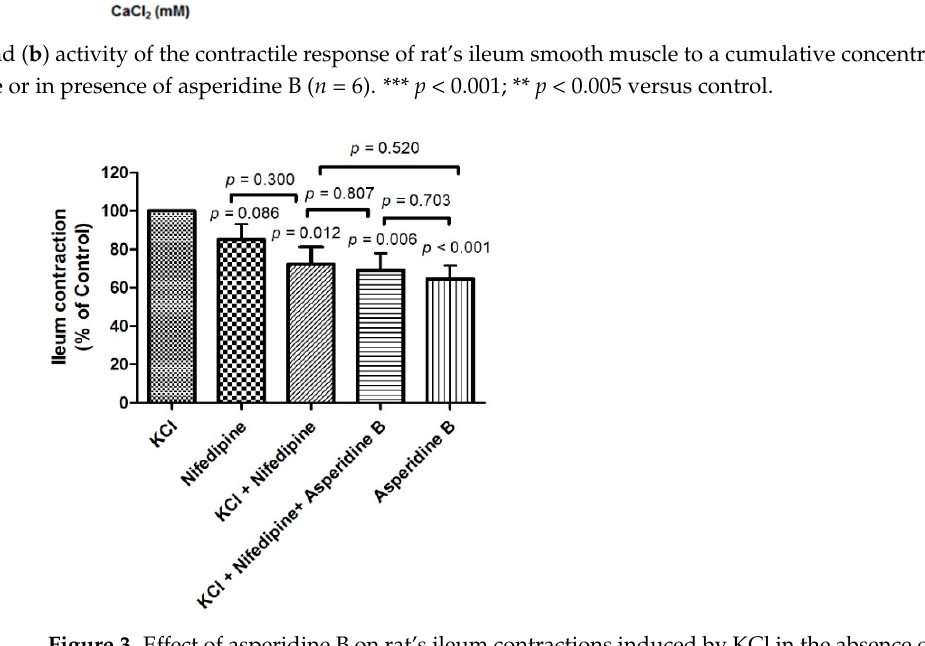
Figure 3. Effect of asperidine B on rat’s ileum contractions induced by KCl in the absence or presence of 1 µM nifedipine ( n = 6). The differences of the tested compounds, except specific comparator, indicated that it compared with KCl.